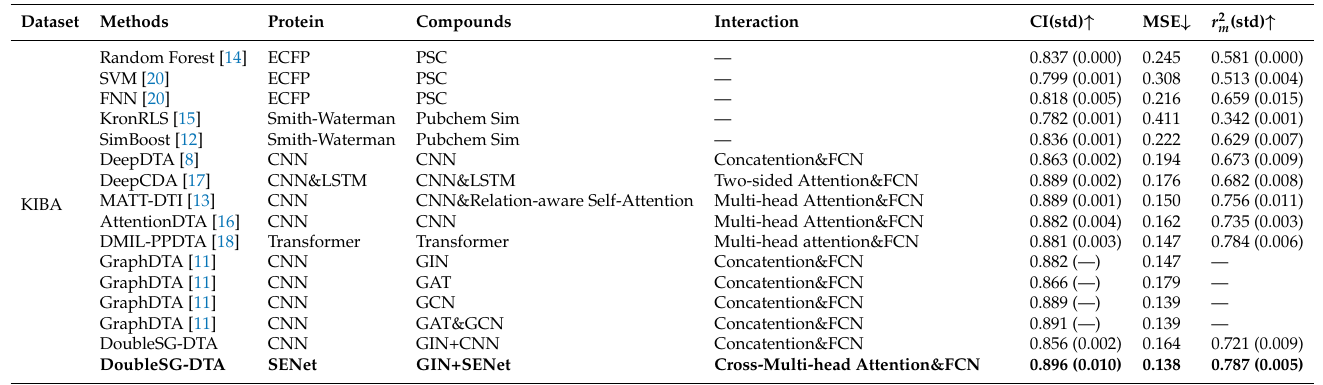
Table 4. Comparison of previous studies and the DoubleSG-DTA on the KIBA dataset.